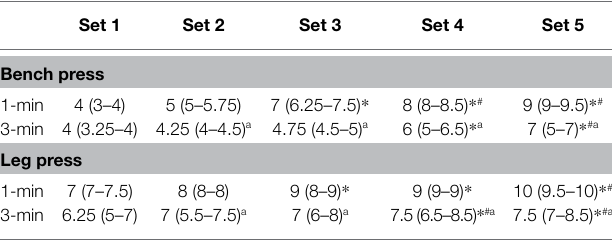
TABLE 2 | Rating of perceived exertion (RPE). Post-set values for both exercises for the 1- and 3-min rest conditions [median (25%–75%)]. Set